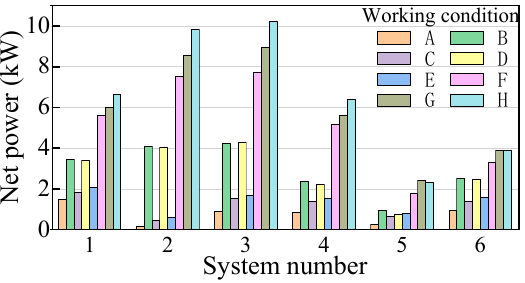
Figure 16. Under 15 °C net power of each system under different working conditions.